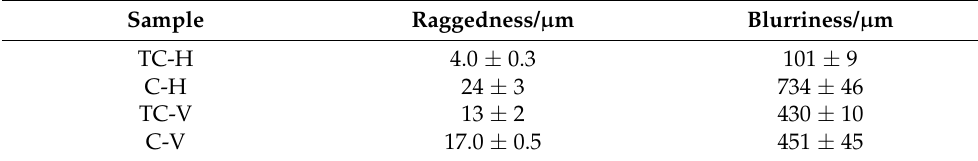
Table 2. Average edge raggedness and blurriness values for the thermochromic horizontal edge (TC-H), conventional horizontal edge (C-H), thermochromic vertical edge (TC-V), and conventional vertical edge (C-V). Sample Raggedness/ µ m Blurriness/ µ m